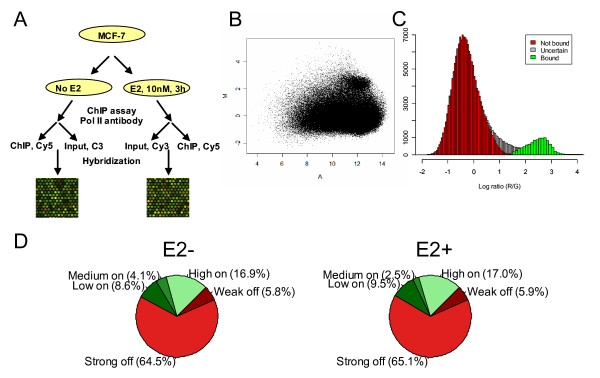
ChIP-chip procedure (A). MA plot for a control experiment, after normalization (B; M = log2(Red/Green); A = log2(Red*Green)/2). Fit of the gamma+normal model to the log ratio of red versus green channels (C). The red portion of the histogram shows probes that belong to the unbound distribution with p < 0.05. The green portion of the histogram are probes that belong to the bound distribution with p < 0.05. The grey areas in between are ambiguous. Our model allows us to annotate promoters as being active or inactive at different confidence levels (D). "High on" indicates strong evidence for RNA Polymerase II binding in both replicates (the probes fall within the green portion of panel C); "Medium on" indicates strong evidence for RNA Polymerase II binding in one replicate, and weak evidence in the other (i.e., the probes fall outside of the red area in panel C). "Low on" indicates weak evidence in both replicates. "Low off" indicates inconsistency between the replicates, and finally "Strong off" indicates a high probability that no binding occurred (i.e., probes fall within the red portion of panel C).